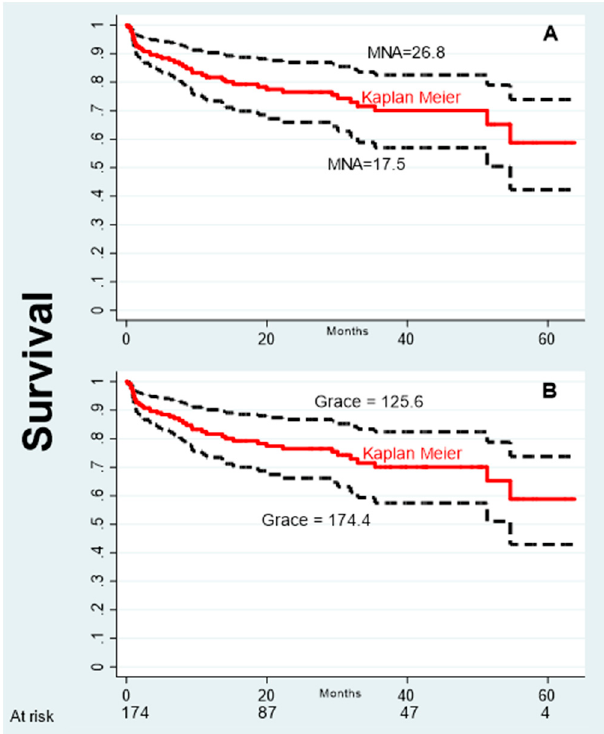
Figure 1. ( A ). Survival curves (dashed black lines) at specific values of mini nutritional assessment (MNA) (mean ± 1 SD) obtained from the Cox model adjusting for the GRACE Score at the values observed in the study population (directly adjusted curves). ( B ) Survival curves (dashed black lines) at specific values of GRACE Score (mean ± 1 SD) obtained from the Cox model adjusting for the MNA score at the values observed in the study population. KM, overall Kaplan–Meier curve (continuous red line).